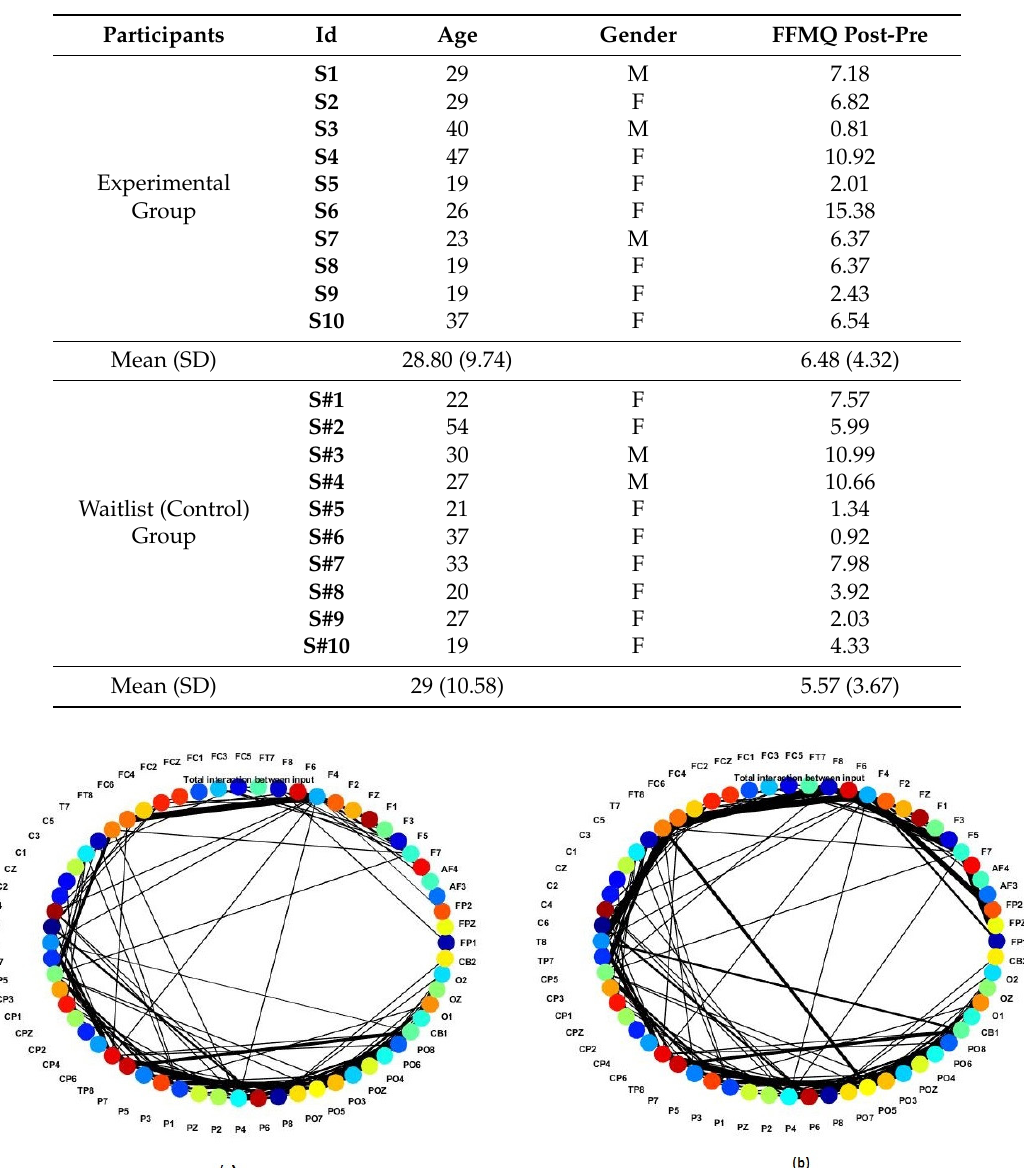
Table A1. Descriptive information of all participants and their FFMQ (Post-Pre) score.